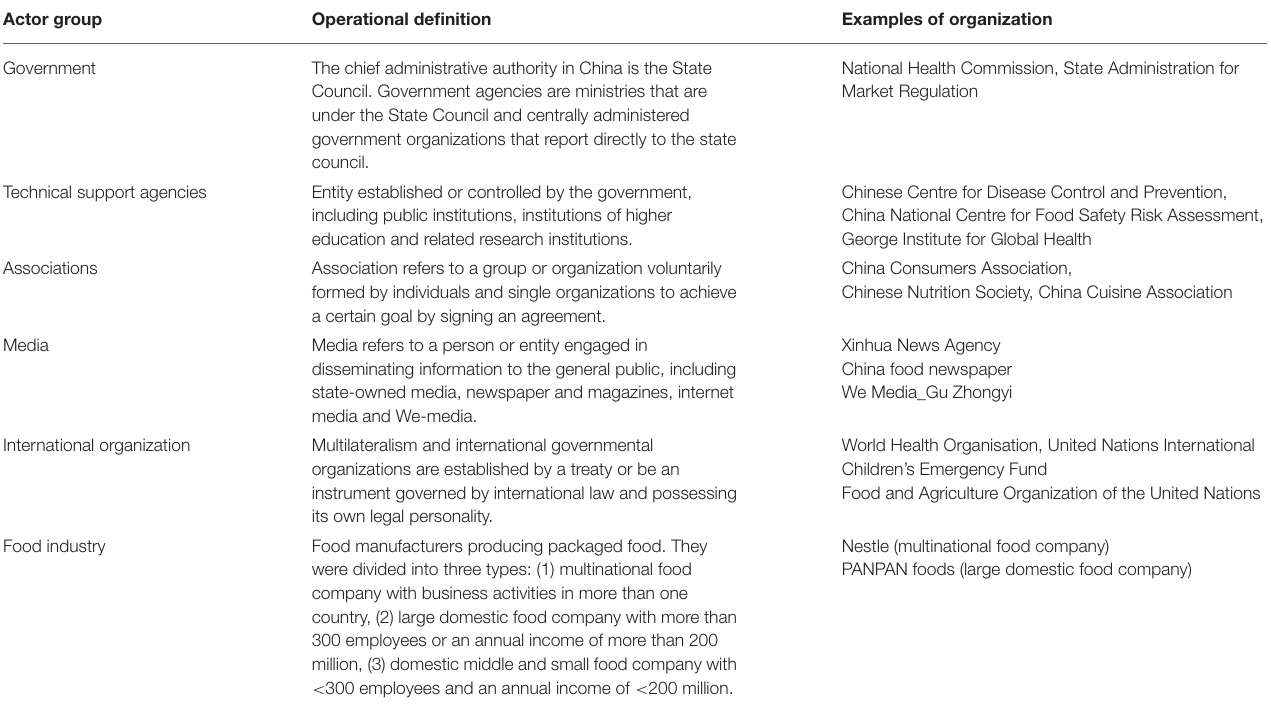
TABLE 2 | Definition of actor groups.